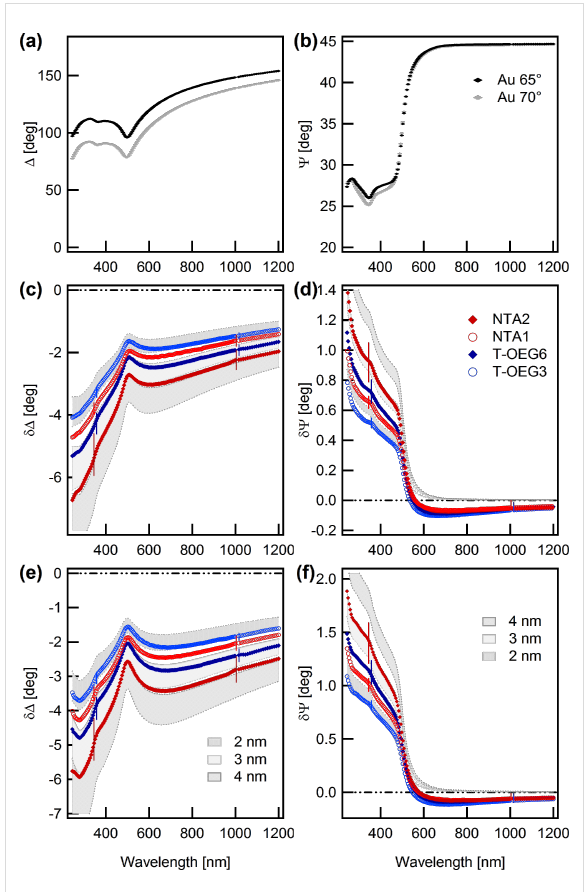
Figure 2: (a,b) Ex situ experimental SE spectra obtained on gold sub- strates. (c–f) Ex situ experimental difference spectra ( δΔ 1,0 = Δ 1 − Δ 0 , δΨ 1,0 = Ψ 1 − Ψ 0 ) obtained for NTA2 (red full diamonds) and NTA1 (red open circles) SAMs. Panels c and d: 65° angle of incidence, panels e and f: 70° angle of incidence. Data from T-OEG6 and T-OEG3 SAMs [49] are also shown for reference. Thin vertical bars represent the experimental uncertainty related to data dispersion over the investigated samples. Shaded areas illustrate the results of simula- tions based on the TF|Au model, for three values of the SAM thick- ness ( d TF = 2, 3 and 4 nm). For δΔ 1,0 patterns (left) the top and bottom borders of the shadings correspond to n TF = 1.35 and 1.50, respective- ly. For the δΨ 1,0 spectra (right panels) the order is reversed.